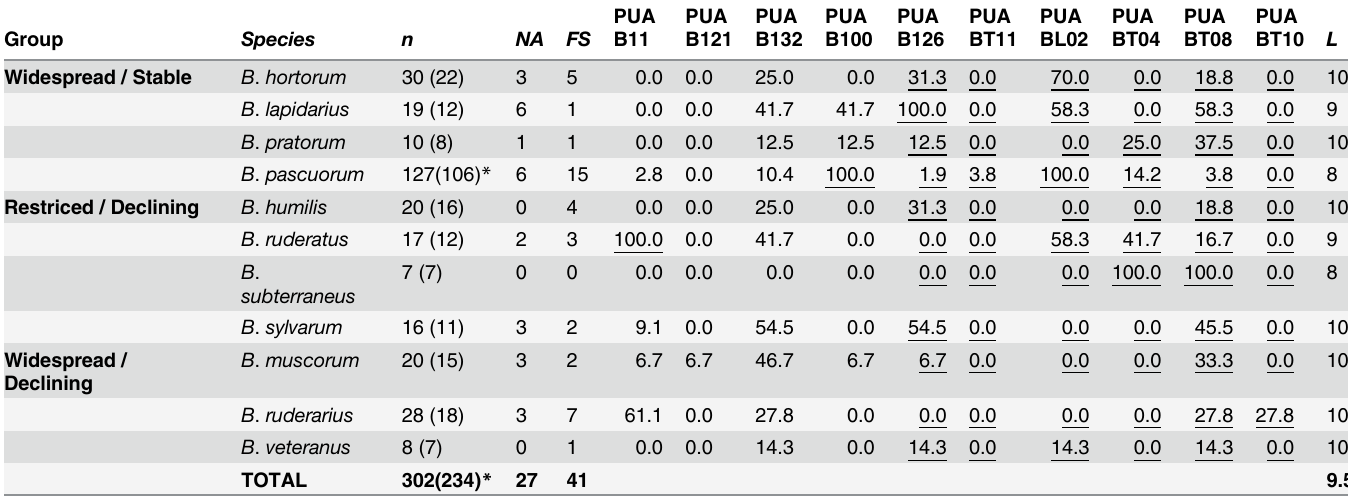
Table 1. Scoring efficiency of the microsatellite loci for each Bombus spp.